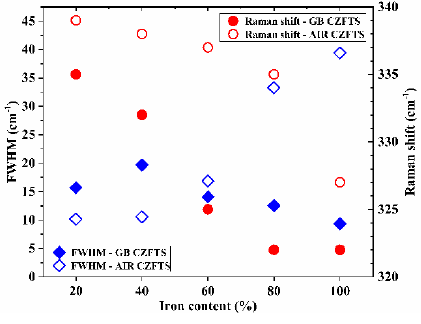
Figure 4. Raman shift position and FWHM of the main peak for the 20%, 40%, 60%, 80%, and 100% C(Z,F)TS thin films, made in glovebox and air.